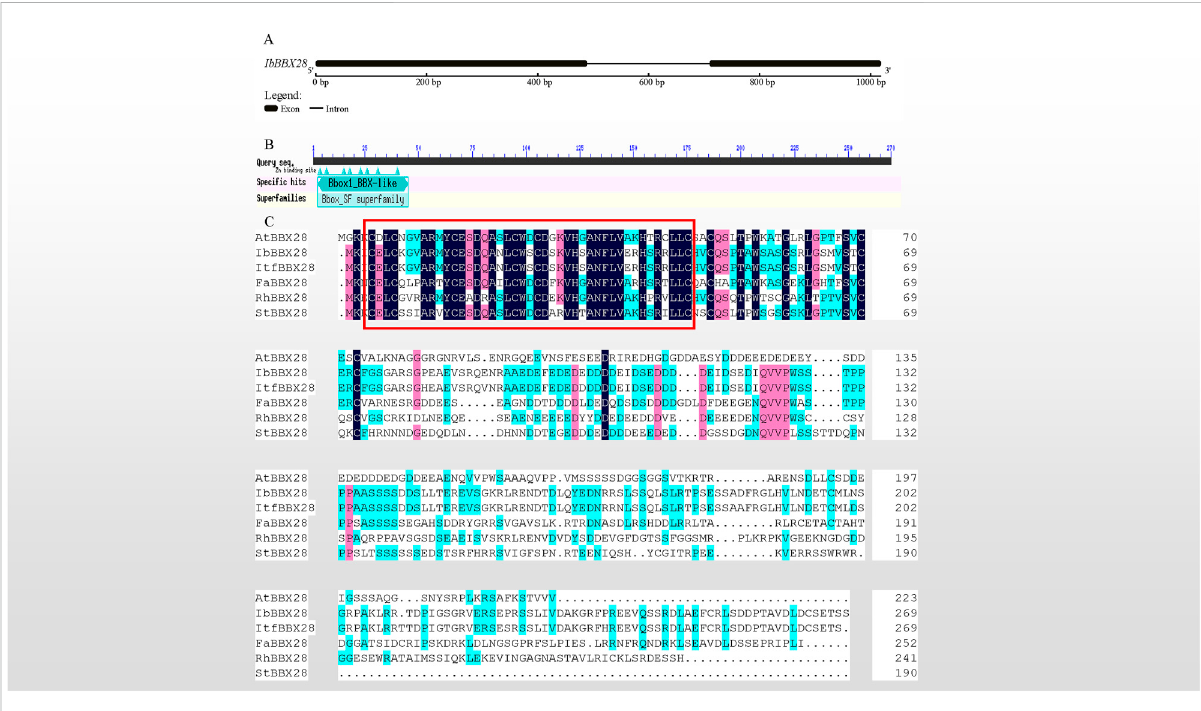
FIGURE 1 Sequence cloning of IbBBX28 , gene structure, and multiple sequence alignment results. (A) The gene structure of IbBBX28 . (B) The structural domain of IbBBX28 obtained by the CD-search in the NCBI. (C) The multiple sequence alignment of IbBBX28 and BBX28 proteins in other species; the sequence in the red box is the B-box domain. The amino acids sequences are: AtBBX28 ( Arabidopsis thaliana , AT4G27310), ItfBBX28 ( I. tri fi da ; Itr_sc000359.1_g00035.1), FaBBX28 ( Fragaria x ananassa , QOI16737), RhBBX28 ( Rosa hybrid cultivar , UCU84643), and StBBX28 ( Solanum tuberosum ,